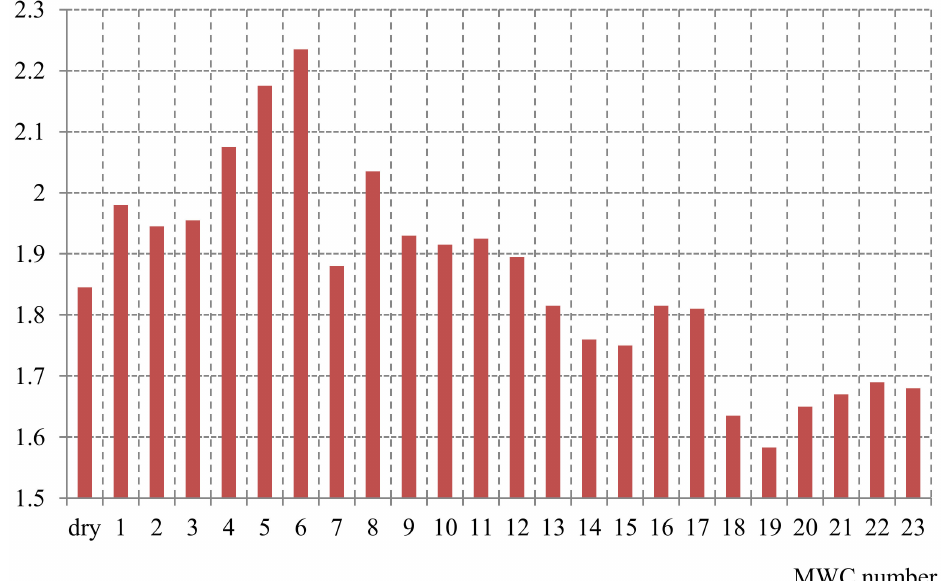
Figure 5. The stretch ratios λ in rolling at 2nd level of